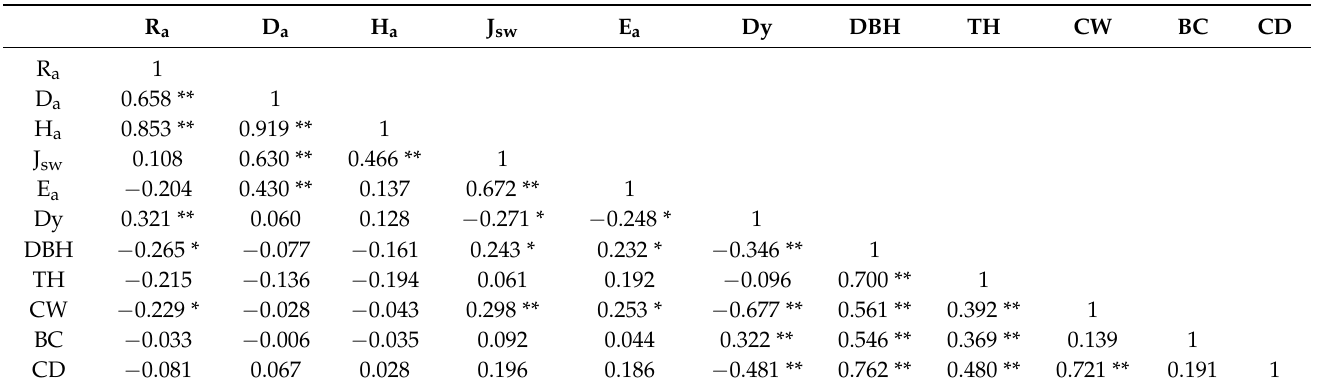
Table 2. Correlation analysis of community structure and species